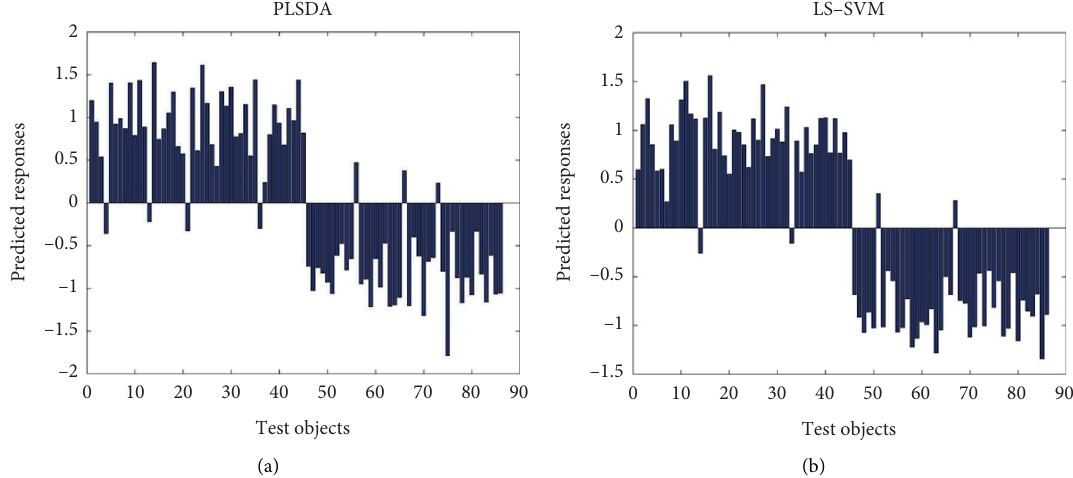
Figure 4: Classifcation results by (a) PLS-DA and (b) LS-SVM. Objects 1–45, free-range eggs; objects 46–86, caged